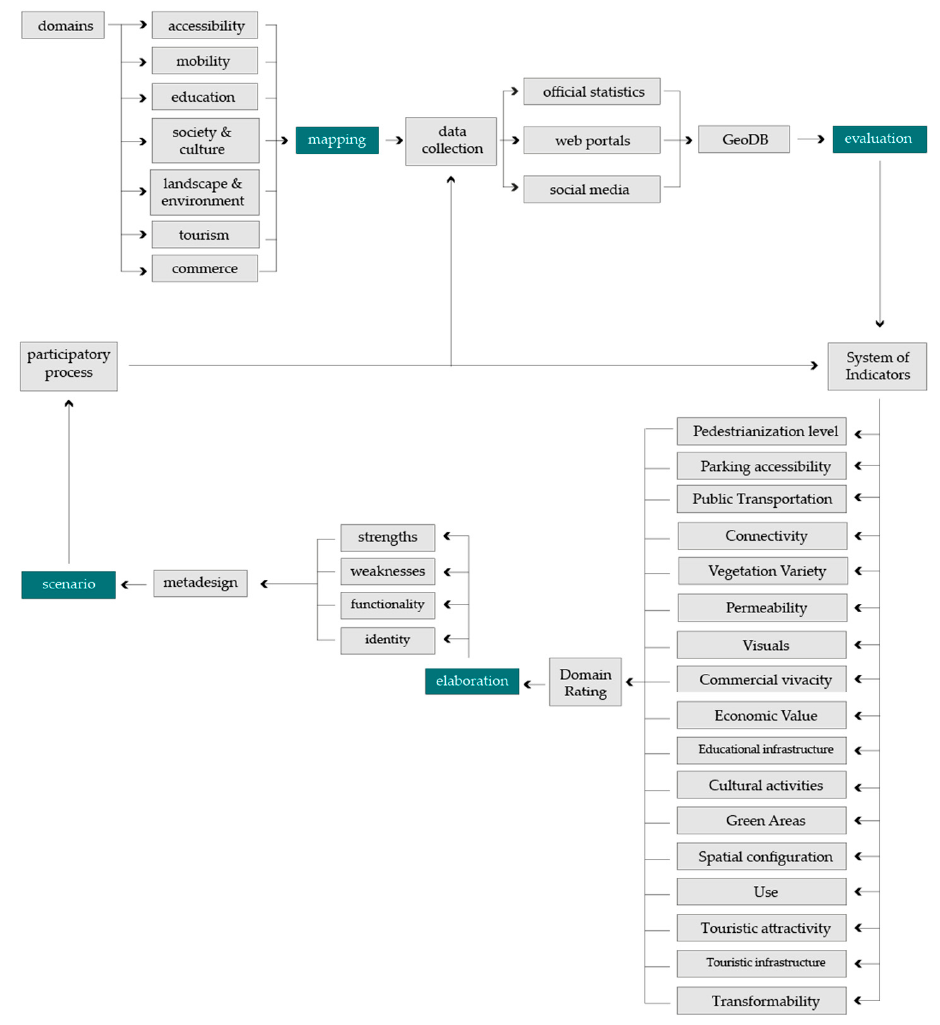
Figure 3. Schema of the workflow.